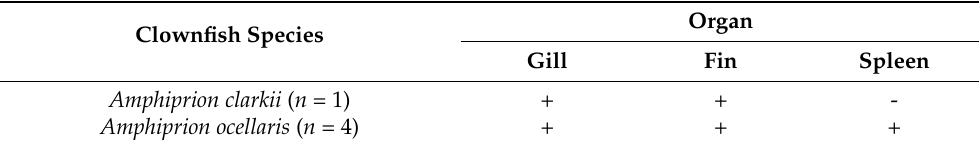
Table 2. Detection of the Lymphocystis disease virus (LCDV) major capsid protein (MCP) gene from different organs of clownfish, Amphiprion spp.